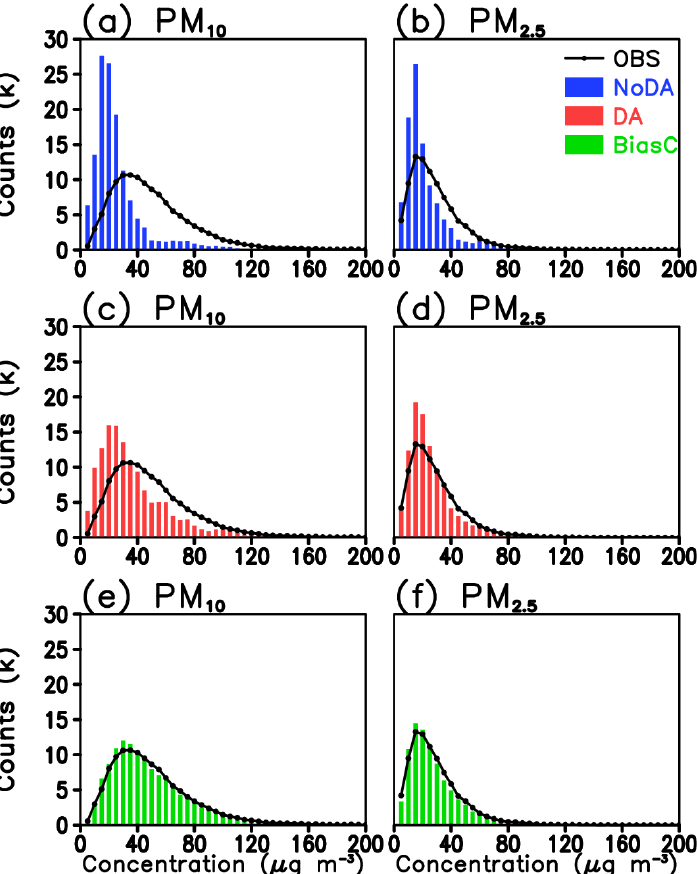
Figure 11. Histograms of the PM 10 (left) and PM 2.5 (right) concentrations from the forecasts by ( a , b ) NoDA, ( c , d ) DA, and ( e , f ) the bias correction (BiasC). All forecasts are the values after 24 h from the start. The solid lines with closed dots indicate the observed values.